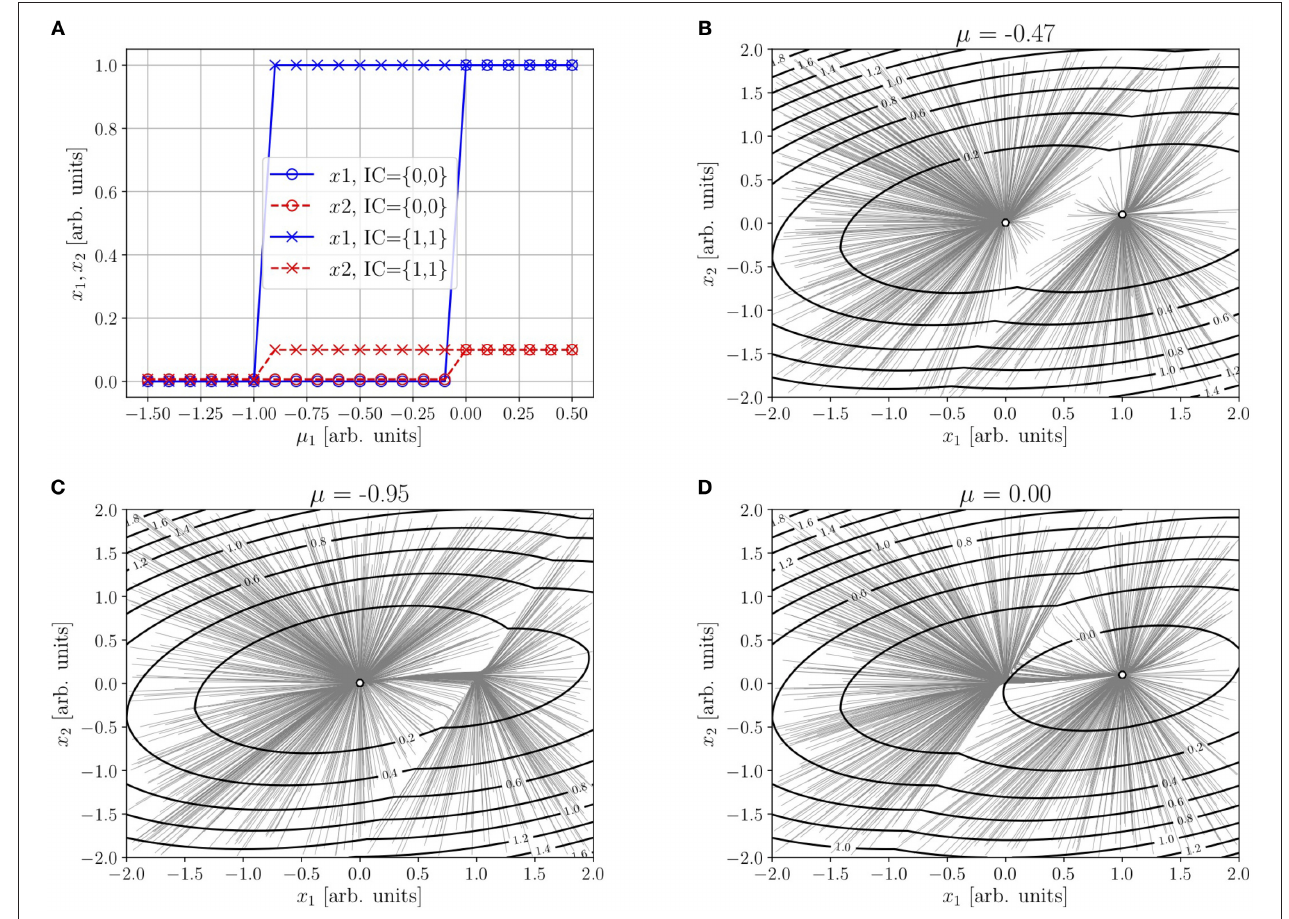
τ 2 1, τ 1 1, µ 2 0.01, ν 1 1, ν 2 0.1, j 11 1, j 22 0.5, j 12 0.5, j 21 0.1. (A) = = = = − = = = = = = ν k θ ( i k ), as functions of µ 1 . Trajectories from = S k ( µ k ) given by Equation (10)—in the equistable case given by Equation (11) (B) , − 10 − 4 . In =